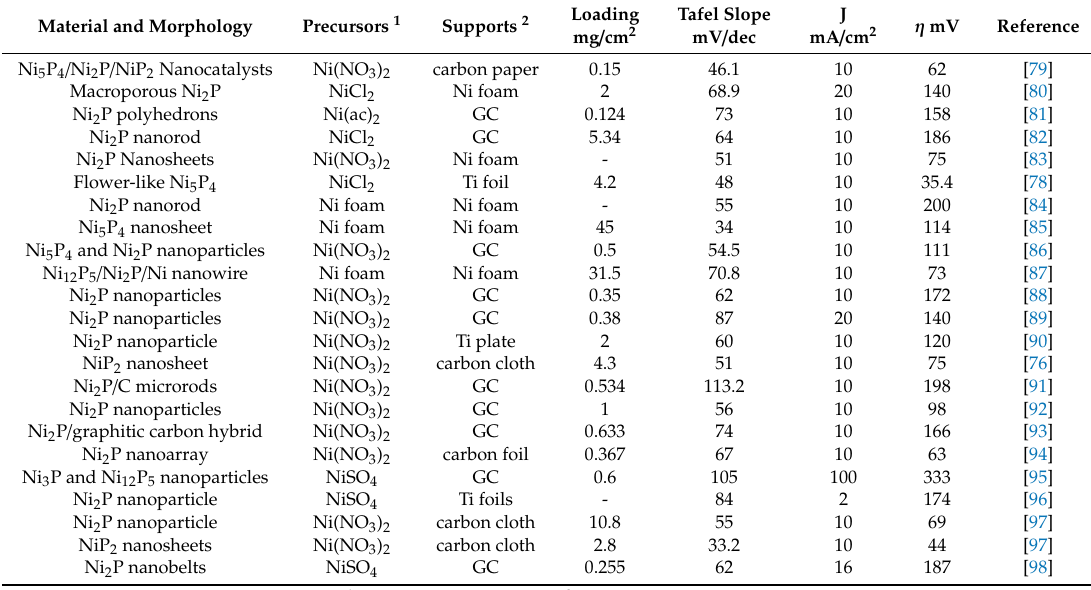
Ni 2 P nanoparticles